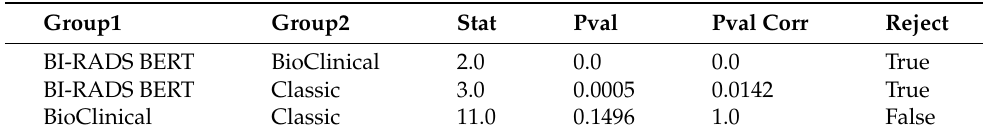
Table A17. Bonferonni-corrected McNemar test results for field extraction with no section segmenta- tion of previous cancer.